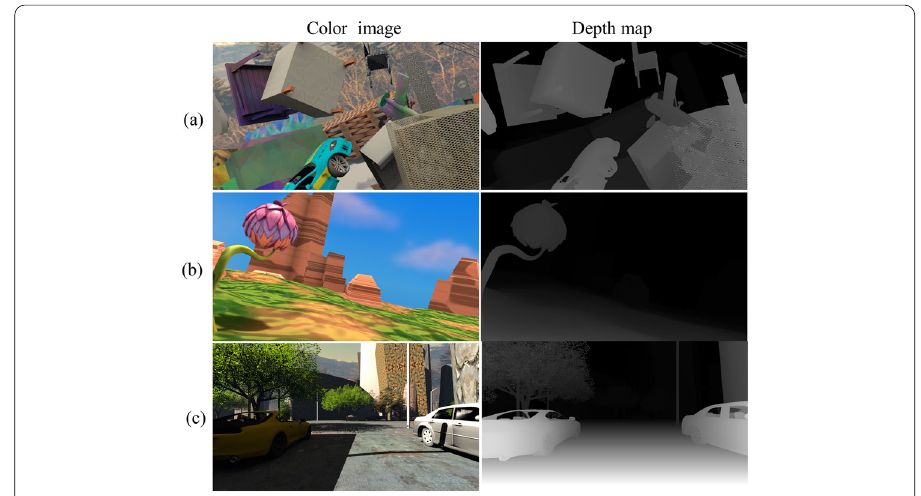
Fig. 9 Examples of color images and their depth maps from: a Flyingthings3D, b Monkaa, c Driving